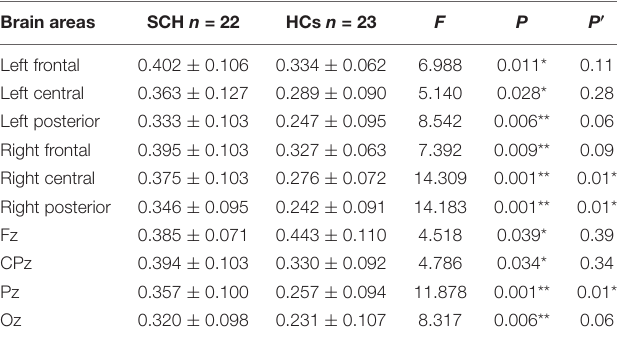
TABLE 4 | Comparison of theta power between schizophrenia and controls with eyes open. Brain